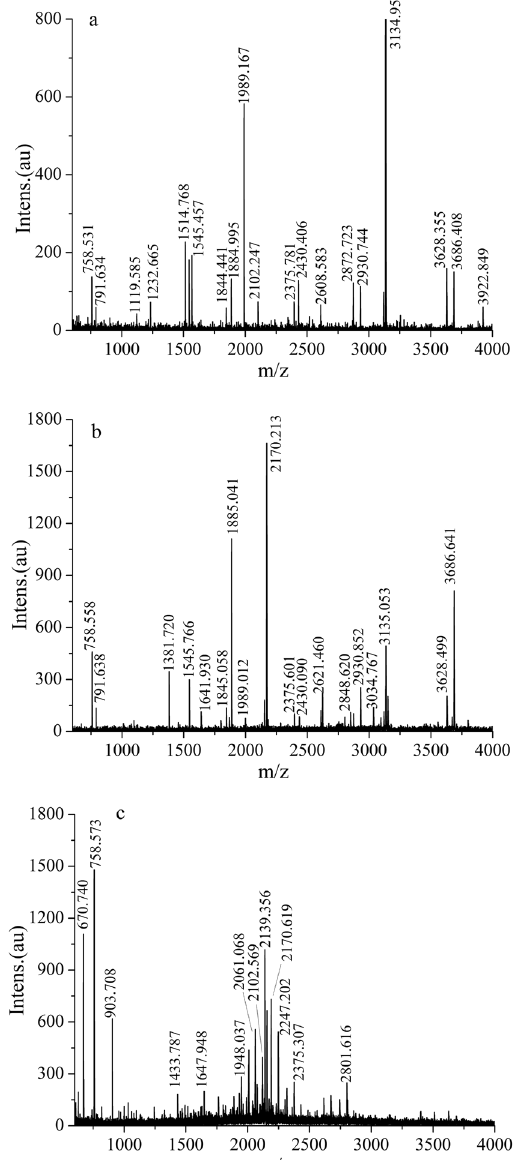
Figure 4. MALDI-TOF MS analysis of purified peptides. ( a ) MALDI-TOF spectrum of purified peptides from the WPI hydrolysate; ( b ) MALDI-TOF spectrum of purified peptides from the top phase; ( c ) MALDI-TOF spectrum of purified peptides from the bottom